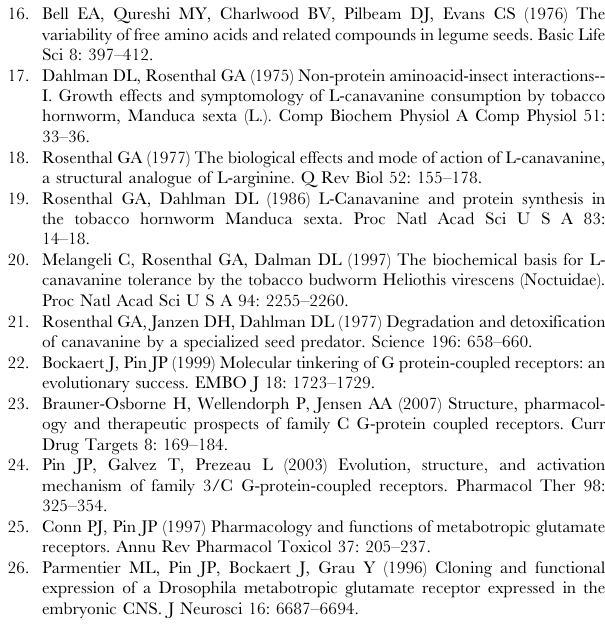
Figure S5. The GRN GAL4 lines drive expression of a GFP reporter in GRNs of the first leg tarsi. The expression patterns of GRN-GAL4 drivers in the first leg tarsi were visualized by GFP epifluorescence. GFP-positive neurons (arrowheads) are observed from either Gr5a-GAL4/UAS-mCD8GFP, Gr66a-GAL4/ UAS-mCD8GFP or NP1017-GAL4/ + ;UAS-mCD8GFP/ + flies. Gr5a- GAL4/UAS-mCD8GFP and NP1017-GAL4/ + ;UAS-mCD8GFP/ + are lateral views. Gr66a-GAL4/UAS-mCD8GFP is an anterior view. Figure S6. Gr66a-GRNs are necessary for L-canavanine- induced PR. By using the Gr66a-GAL4 driver, we targeted the expression of the proapoptotic genes ( rpr and hid ) and the tetanus toxin light chain ( TeT ) to kill and inactivate Gr66a-GRNs, respectively. Results show the percentage of PER and PR on controls ( UAS-rpr:UAS-hid/ + and UAS-TeT/ + ), ablated ( Gr66a/ UAS-rpr:UAS-hid ), and silenced ( Gr66a/UAS-TeT ) Gr66a-GRNs. Note that the PER was not affected in controls as well as when Gr66a-GRNs were ablated or silenced. Compared to controls, which show a high percentage of PR in presence of L -canavanine, the absence or the inactivation of Gr66a-GRNs abolishes the PR response. Behavioral analyses were performed as described in Figure 6. Error bars indicate SEM. Double asterisks indicate significant differences by t -test ( p ,